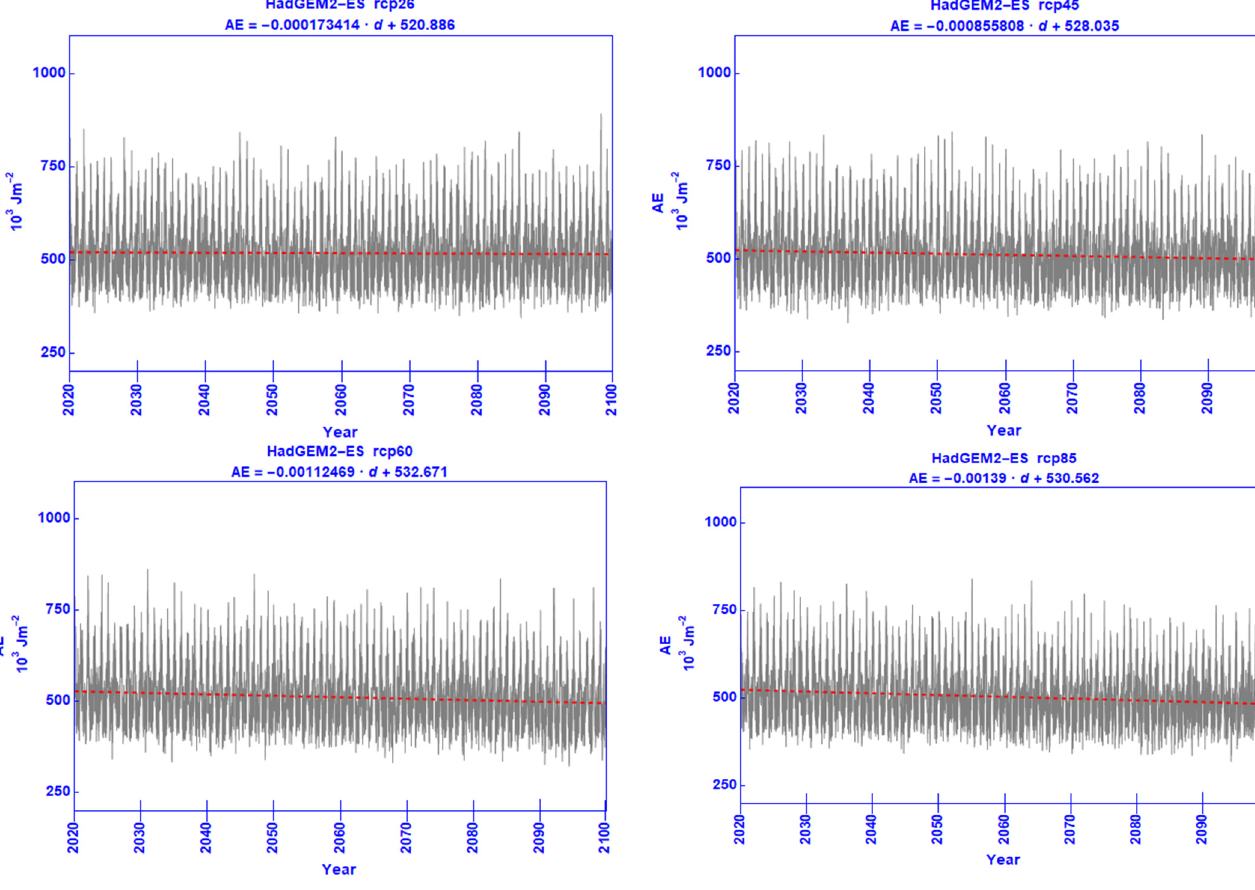
Figure 4. Same as Figure 3 but for AE .